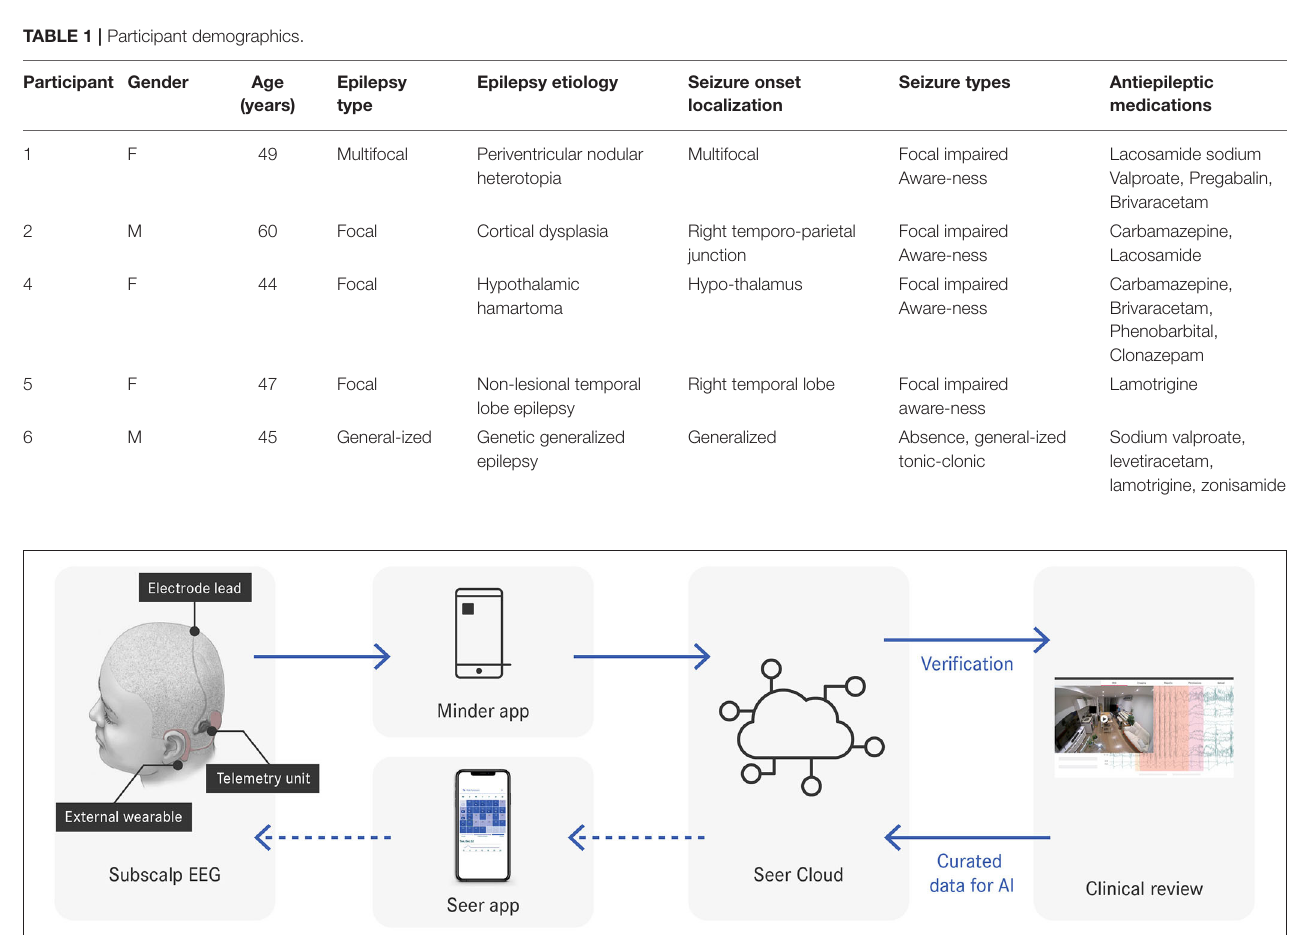
FIGURE 1 | Data flow throughout the system. Dotted arrows indicate system components under